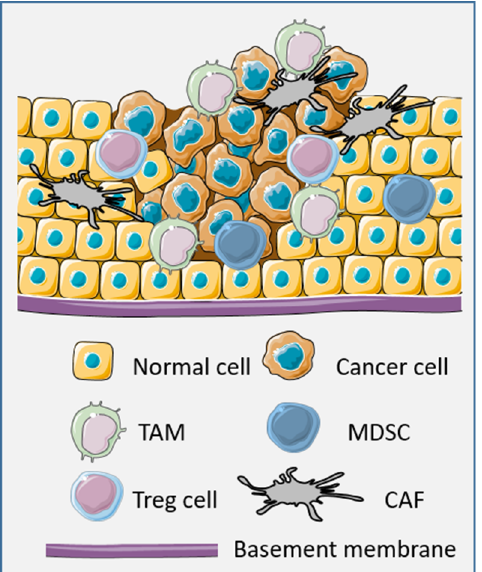
Figure 1. Representation of the tumor microenvironment (TME) with tumor-associated macrophages (TAMs), mesenchymal stromal / stem cells (MSCs), regulatory T-cells (T-regs), and cancer-associated fibroblasts (CAFs) infiltrating the tumor.